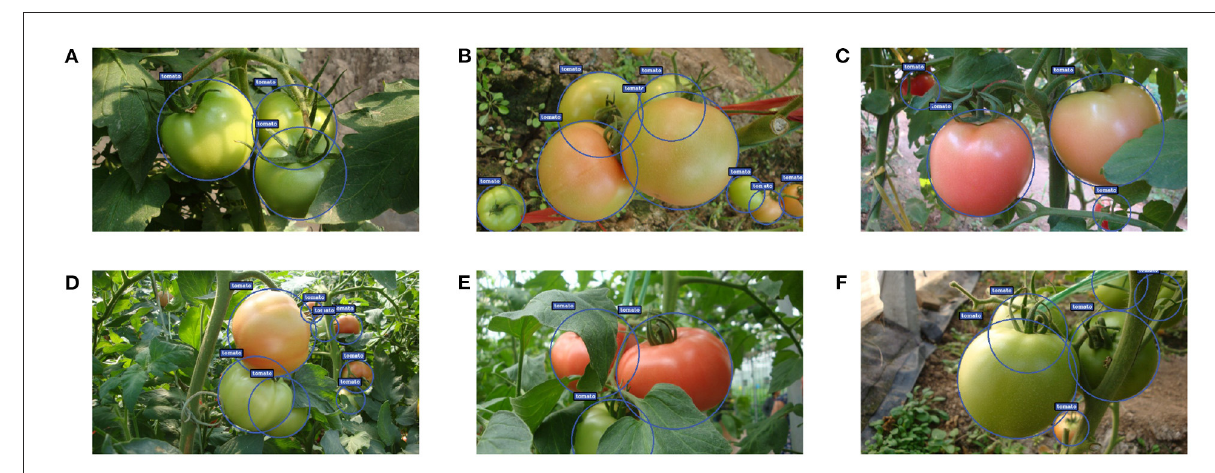
FIGURE14 Some examples of detection results under different occlusion conditions: (A–C) slight cases and (D–F) severe